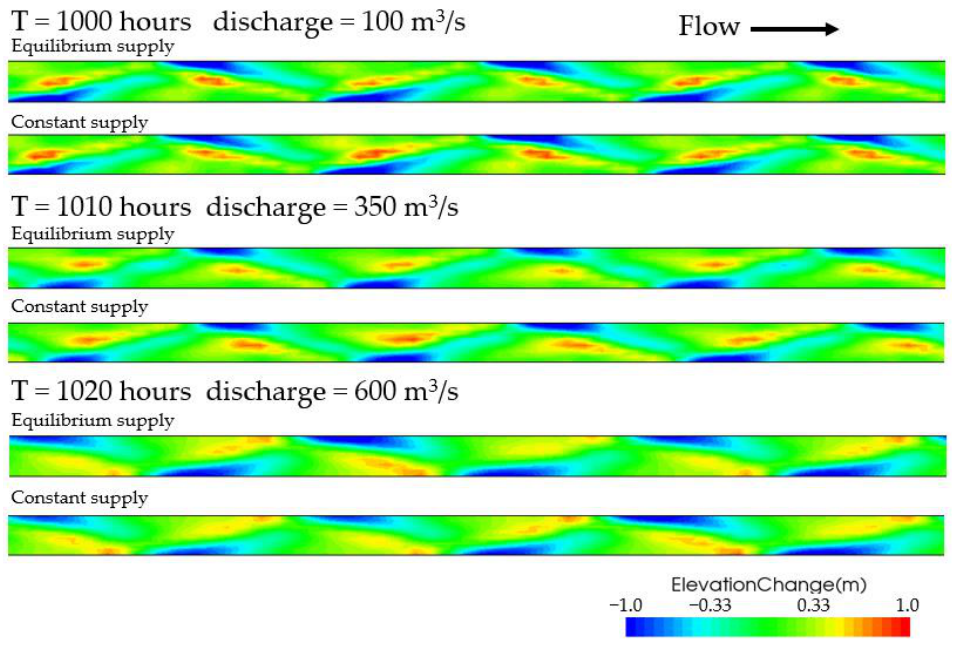
Figure 6. 2D top view of alternate bars simulated in Case 1.